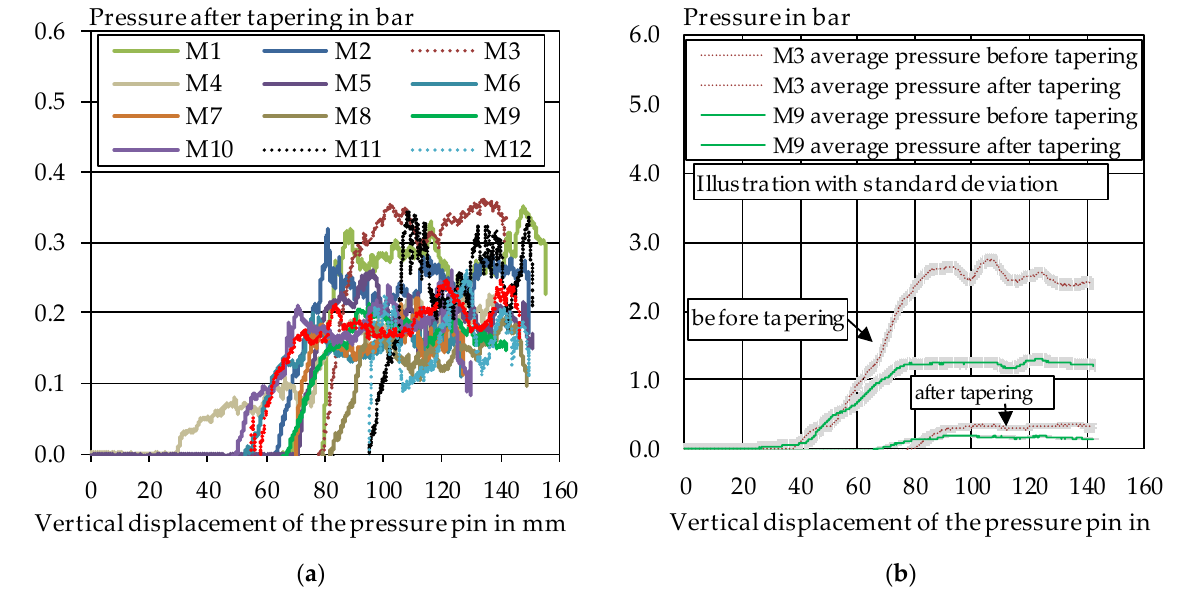
Figure 11. ( a ) Measured pressure during the test immediately after tapering in the capillary rheometer for all compounds. Non-extrudable mixtures are shown as dotted lines, ( b ) measured pressure during the test before and immediately after tapering including standard deviation for M4.